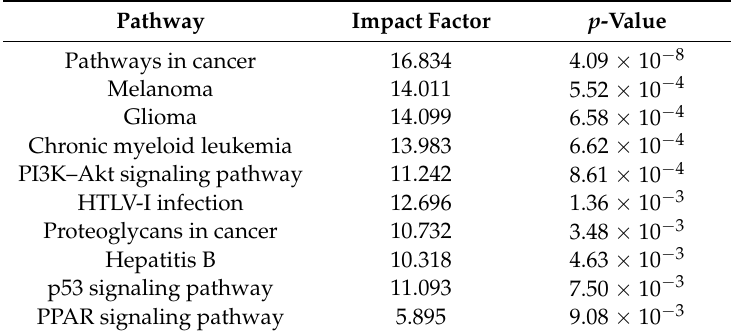
Table 2. Enriched pathways for BLCA driver module ( RXRA , ELF3 , CDKN1A , and RHOA ) performed by MITHrIL using standard KEGG pathways. The pathways are sorted by p -value, and only the pathways with p -value < 0.01 are selected.